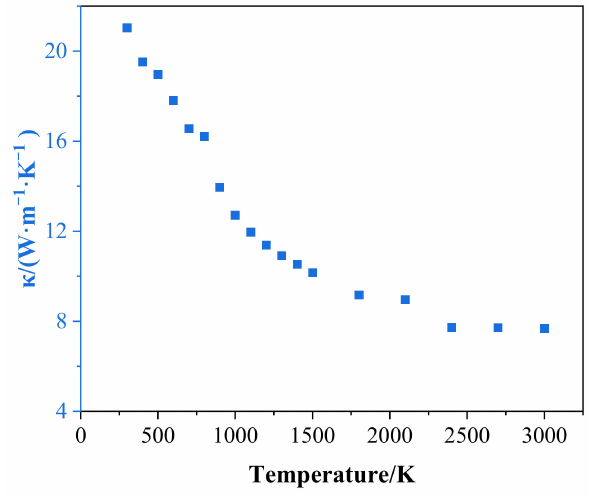
Figure 5. Thermal conductivity of GS-Hs in the substrate temperature range of 300 to 3000